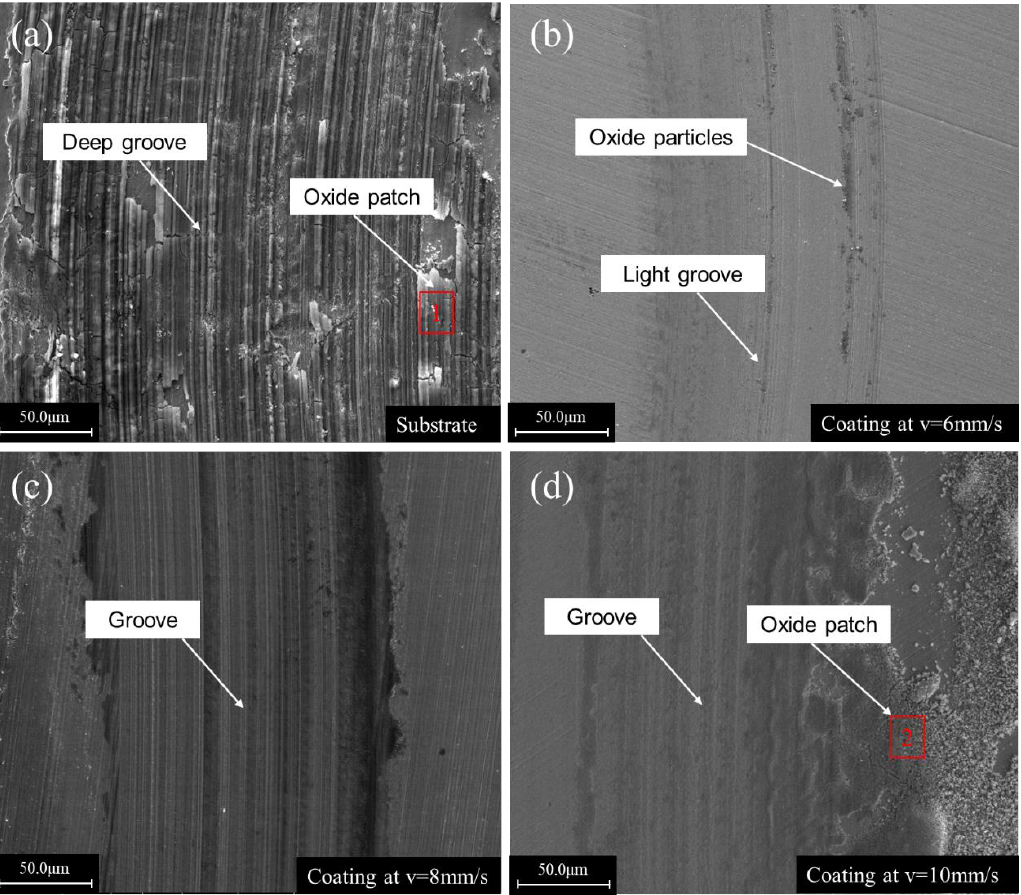
Figure 10. SEM micrographs of the worn surfaces of the substrate and the claddings obtained with different scanning speeds: ( a ) Substrate; ( b ) cladding at 6 mm/s; ( c ) cladding at 8 mm/s; ( d ) cladding at 10 mm/s.